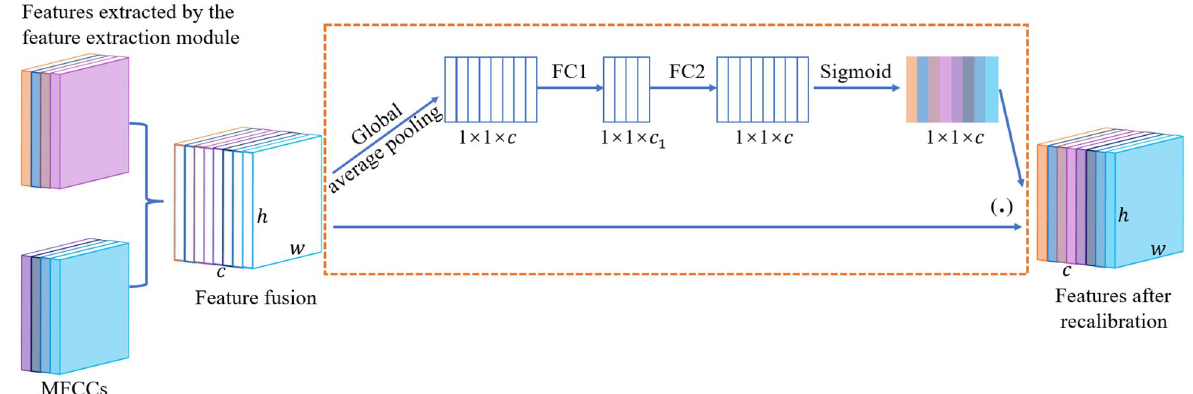
Figure 9. Schematic diagram of SEB used for feature recalibration.